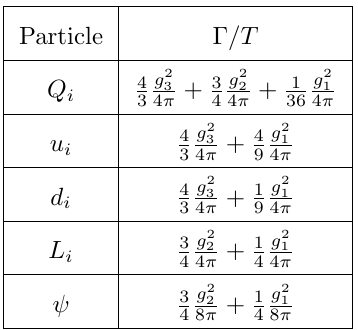
Table 10. Thermal widths used for the VIA approximation